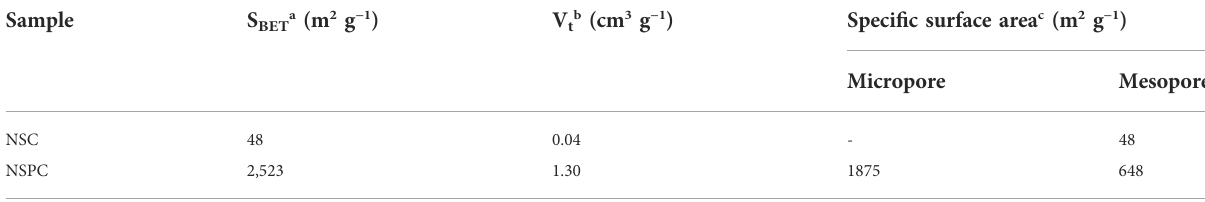
TABLE 1 Pore structure parameters of NSC and NSPC.